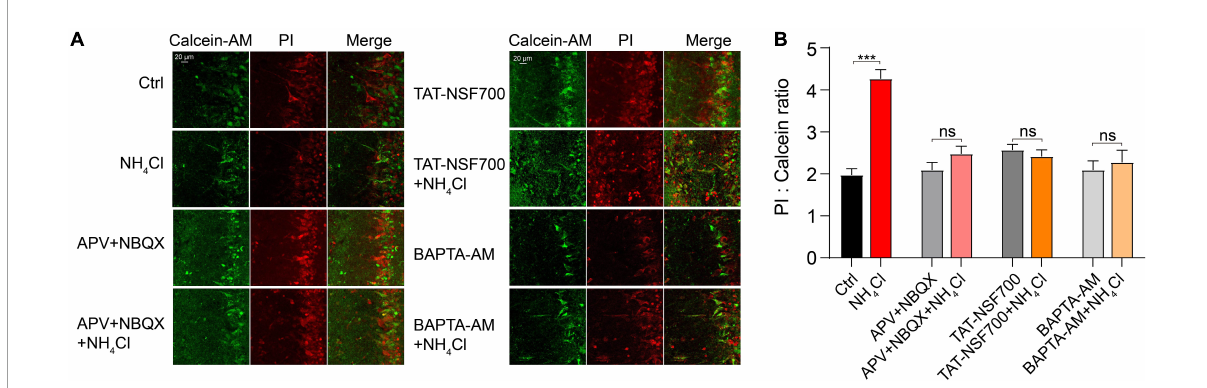
FIGURE7 Ammonium (NH 4 + )-induced overactivation of glutamate receptors exacerbated MCs death. (A) Representative images of live (calcein-AM, Green) and dead cells (PI, Red), and overlay of fluorescence labeling under different experimental conditions with treatment of Ctrl, NH 4 Cl, APV + NBQX, APV + NBQX + NH 4 Cl, TAT-NSF700, TAT-NSF700 + NH 4 Cl, BAPTA-AM, and BAPTA-AM + NH 4 Cl for 1 h. (B) Ratio of dead (PI labeling) to live (calcein labeling) cells for all experiments. Error bars represent standard error; *** p < 0.001; ns, not significant; unpaired Student’s t